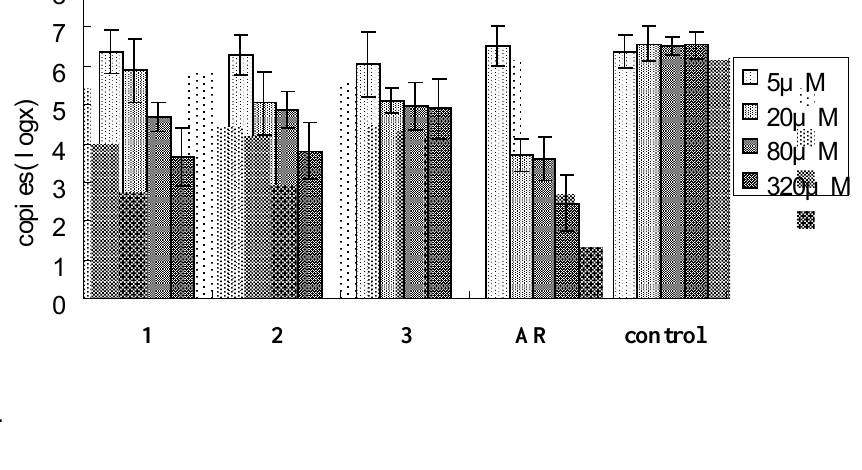
Figure 3. Inhibitory effect of the compounds 1 - 3 on CD40 ligand (CD40L) expression on the membrane of activated platelets stimulated by